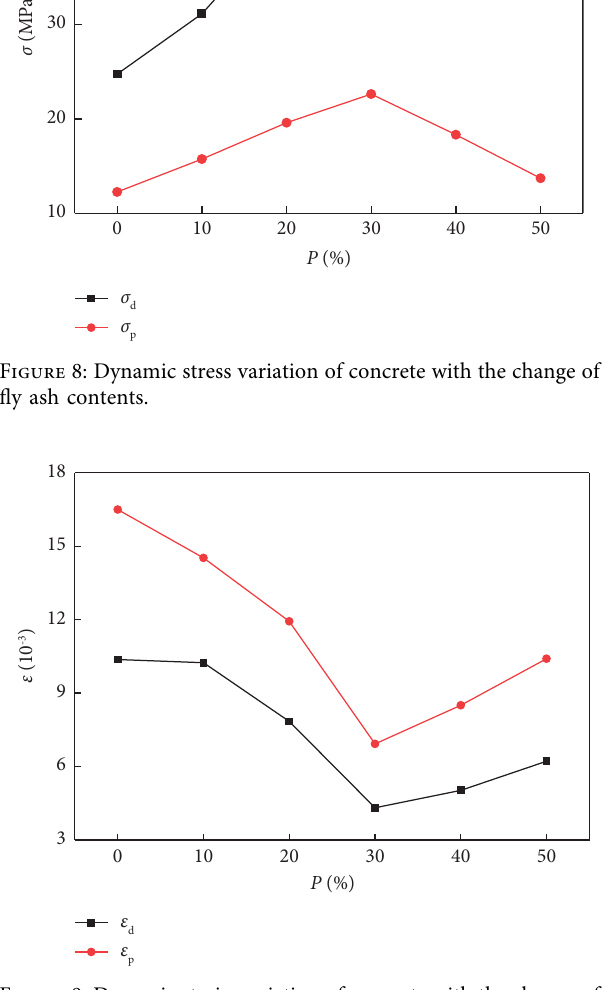
Figure 9: Dynamic strain variation of concrete with the change of fy ash contents.